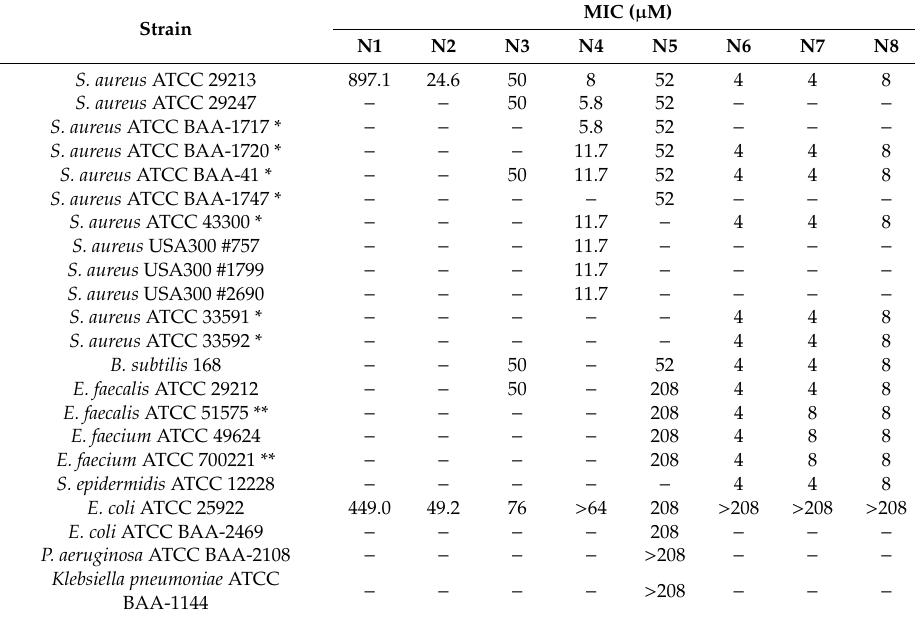
Table 2. MICs of Pyrimidines N1–N8. ATCC—American Type Culture Collection.